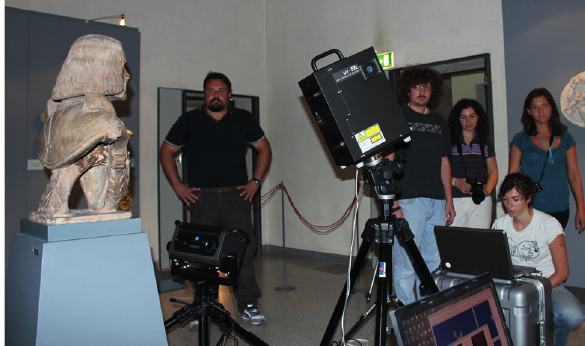
Figure 2: image of the acquisition stage with two range cameras: Minolta Range 7 (centre) and Minolta Vivid 9i